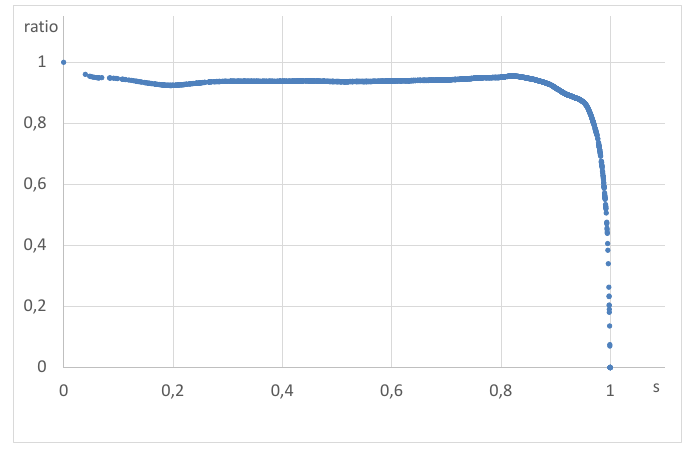
Figure 1: Ratio ˆ g sym ( s )/ g Cl ( s ) for θ = 1